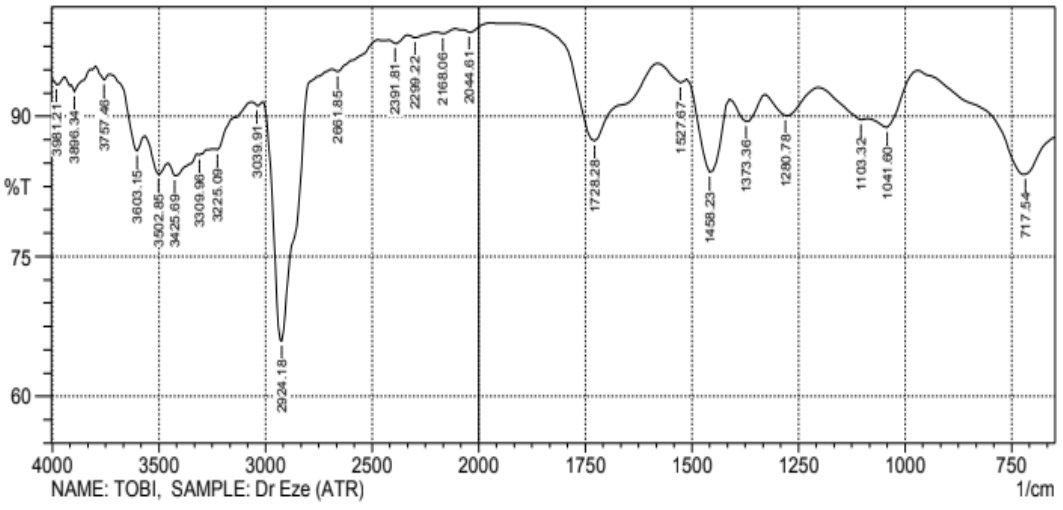
Figure 1. Produced biodiesel FTIR analysis for functional groups.